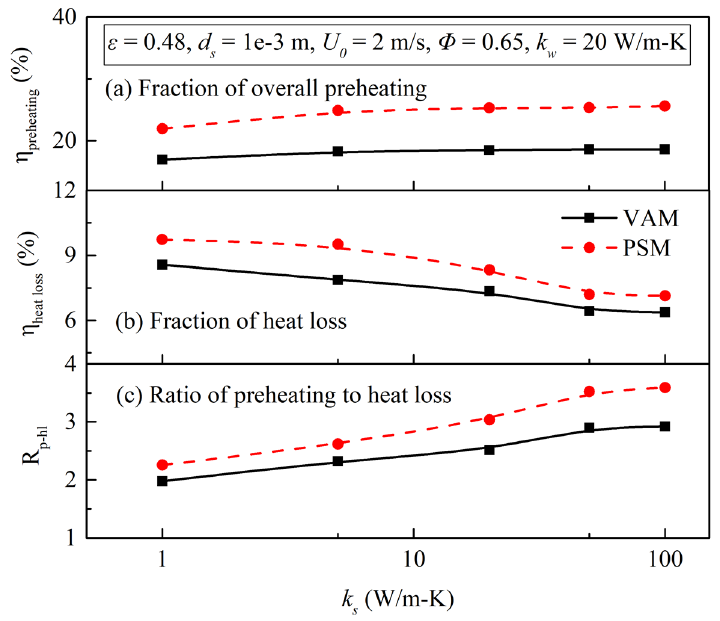
Figure 14. Effects of k s on the ratio of preheating to heat loss obtained by the PSM and VAM. Combining the model difference between the PSM and VAM in terms of flame sta-